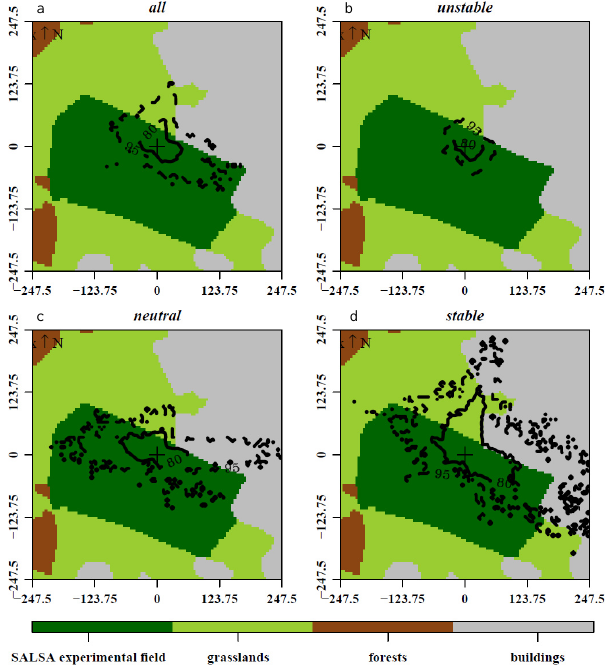
Figure 3: Averaged cumulative footprint contours showing the footprint areas for 80 % (solid 2 Fig. 3. Averaged cumulative footprint contours showing the foot- line) and 95 % (dotted line) of the total flux measured by eddy covariance for (a) all, (b) 3 print areas for 80% (solid line) and 95% (dotted line) of the total unstable, (c) neutral, and (d) stable conditions. x-axis and y-axis are distances from the mast 4 flux measured by eddy covariance for (a) all, (b) unstable, (c) neu- (in meter). The analysis was performed for all data from 29 August to 20 September 2005. 5 tral, and (d) stable conditions. x axis and y axis are distances from the mast (in metre). The analysis was performed for all data from 29 August to 20 September